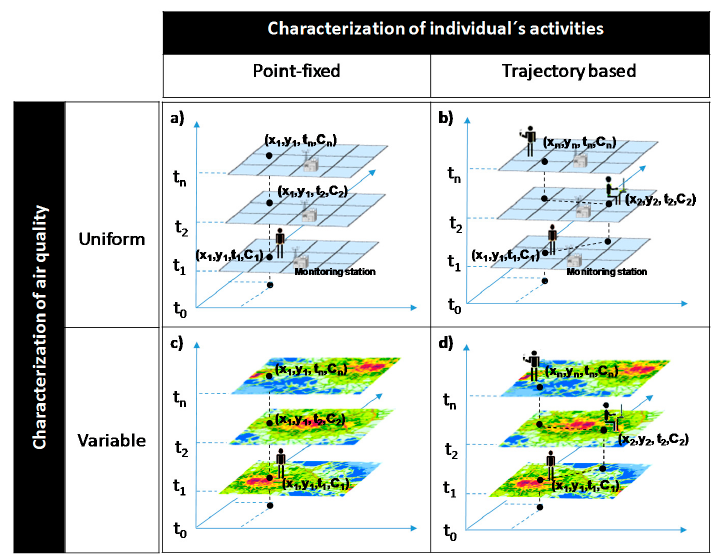
Figure 2. Combination of the classification criteria for personal exposure assessment: ( a ) individual point-fixed activities and uniform air quality approach; ( b ) trajectory based and uniform air quality approach; ( c ) individual point-fixed activities and space-variable air quality approach; ( d ) trajectory based and space-variable air quality approach.